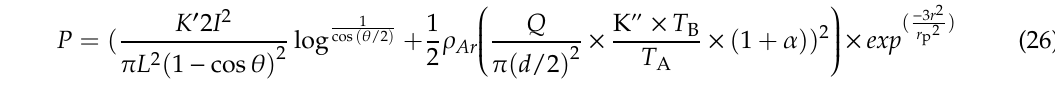
Figure 6. Schematic diagram of the boundary conditions. Table 3. Conditions. Boundary